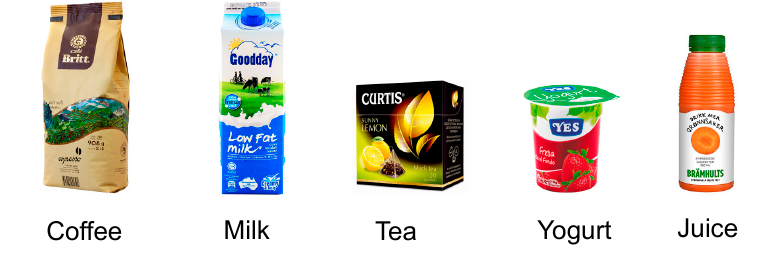
Figure 1. Stimuli used in Study 1.